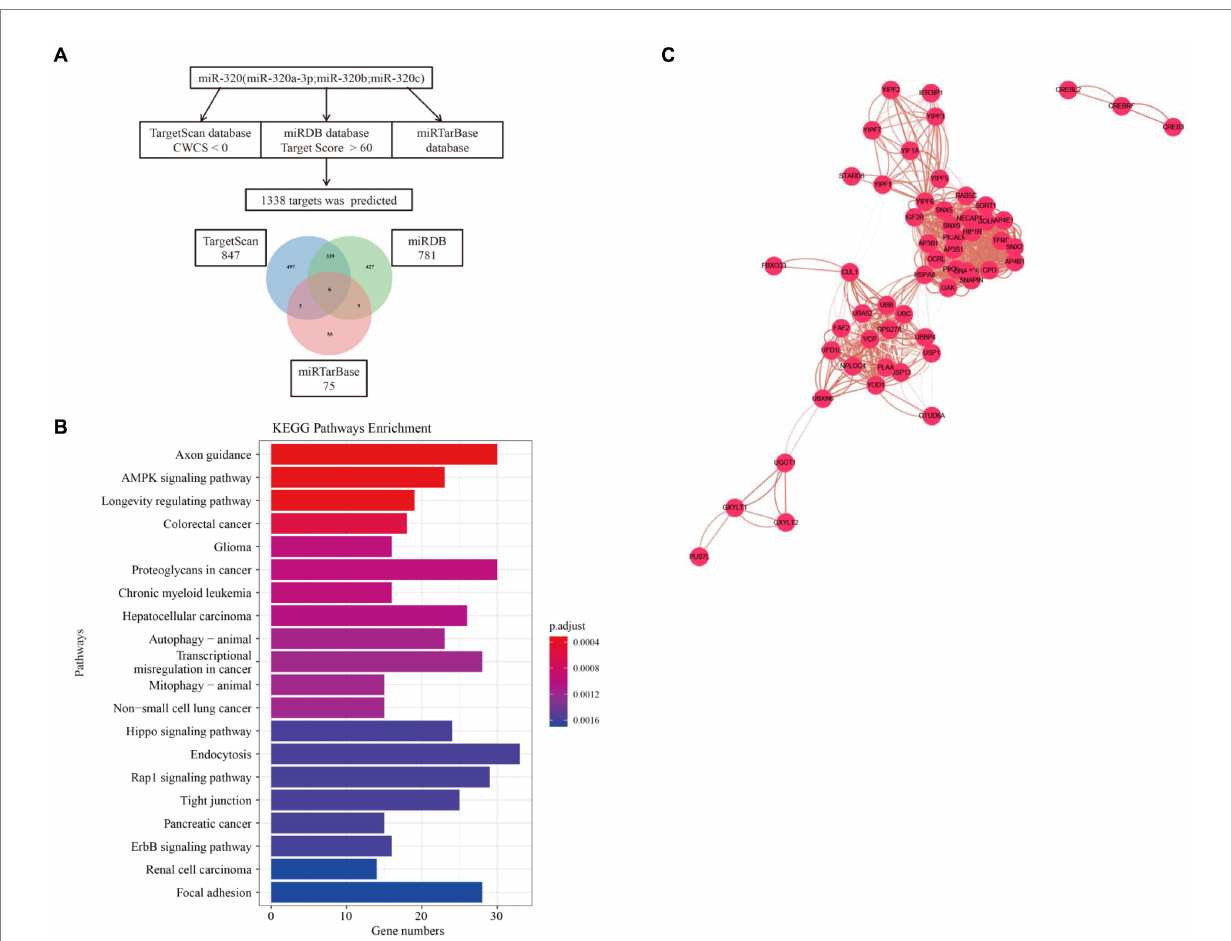
FIGURE 5 Target and pathway prediction for miR-320. (A) miRNAs target prediction workflow using miR-320a-3p, miR-320b, and miR-320c. (B) Top 20 canonical pathways associated with the predicted mRNA targets. (C) The PPI network of overlaped genes was generated using STRING and visualized with Cytoscape. PPI, protein-protein